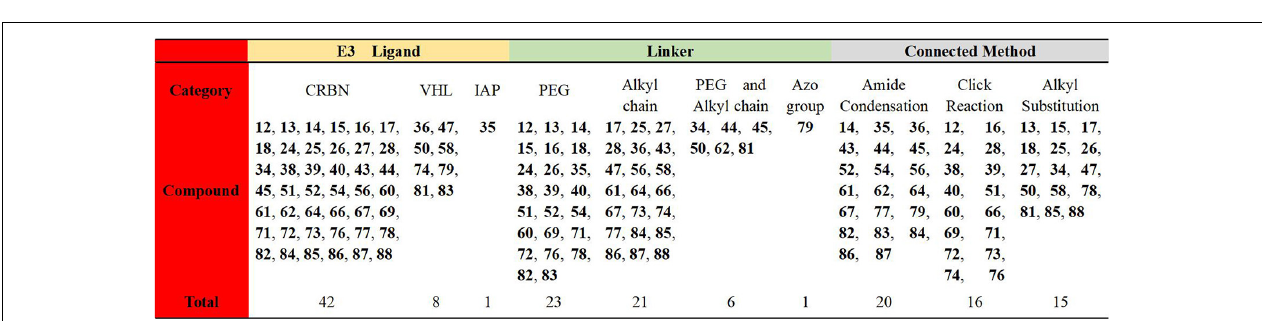
FIGURE 15 | Summary of structure analysis of optical control degraders. (A) Targets used in loptical control degraders. (B) E3 ligands used in loptical control degraders. (C) Photoprotecting groups used in loptical control degraders. (D) Modified position in loptical control degraders. (E) The reversibility in loptical control degraders.